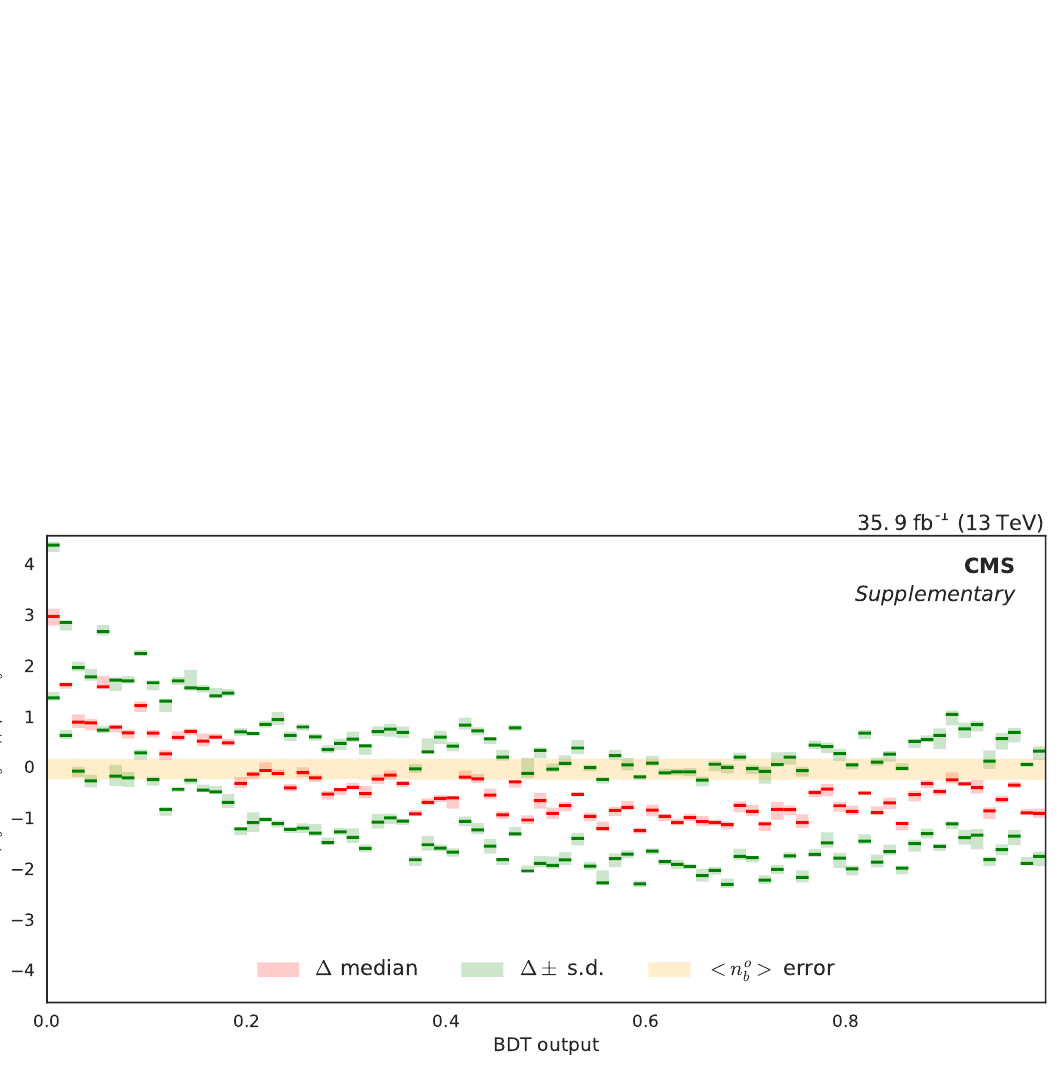
Figure 12 . Bias estimation by resampling, in relative units of the statistical uncertainty of the predicted background, used to correct the background estimation. The median (red line) and the upper and lower one s.d. quantiles (green lines) have been computed from 200 subsamples of the re-mixed data comparing the predicted background n p with the observed n o . The variability due b b to the limited number of subsamples is estimated by bootstrap and it is shown for each estimation using a coloured shadow around the quantile estimation. The light yellow shadow represents the uncertainty due to the limited statistics of the reference observed sample. The separation between the one s.d. quantiles is compatible with the expected variance if the estimation was Poisson or Gaussian